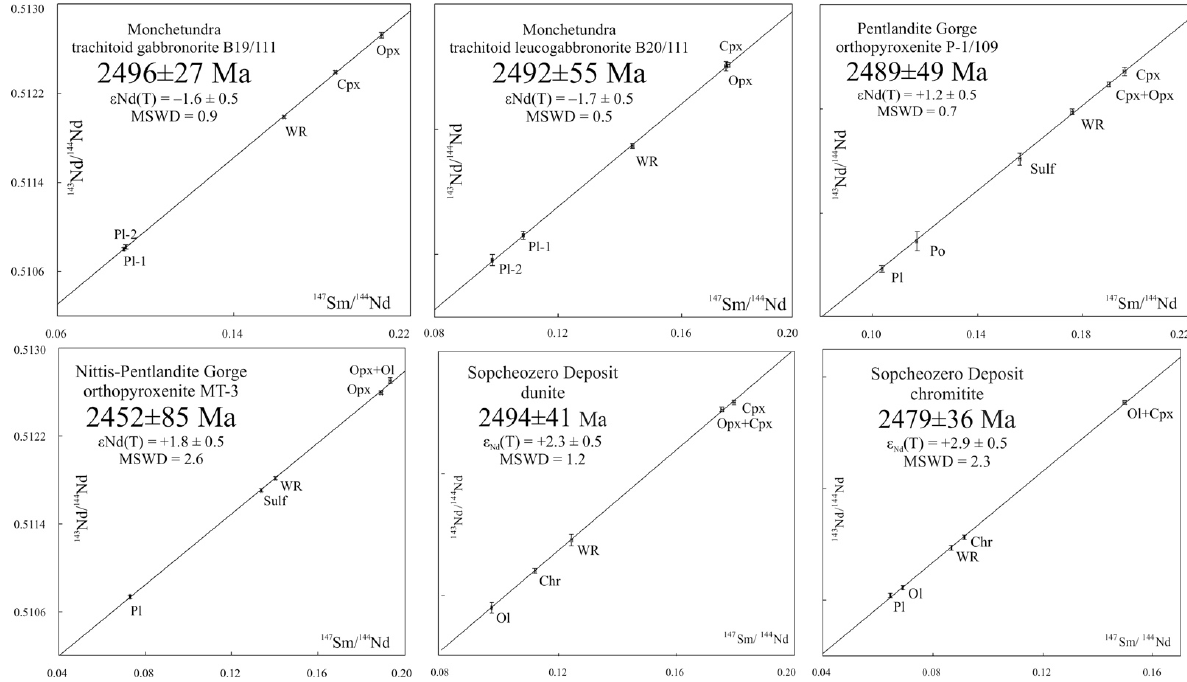
Figure 8. Mineral Sm-Nd isochrones for rocks of the Monchetundra area. The Sm-Nd mineral isochron for orthopyroxene, olivine, plagioclase, sulfide miner-